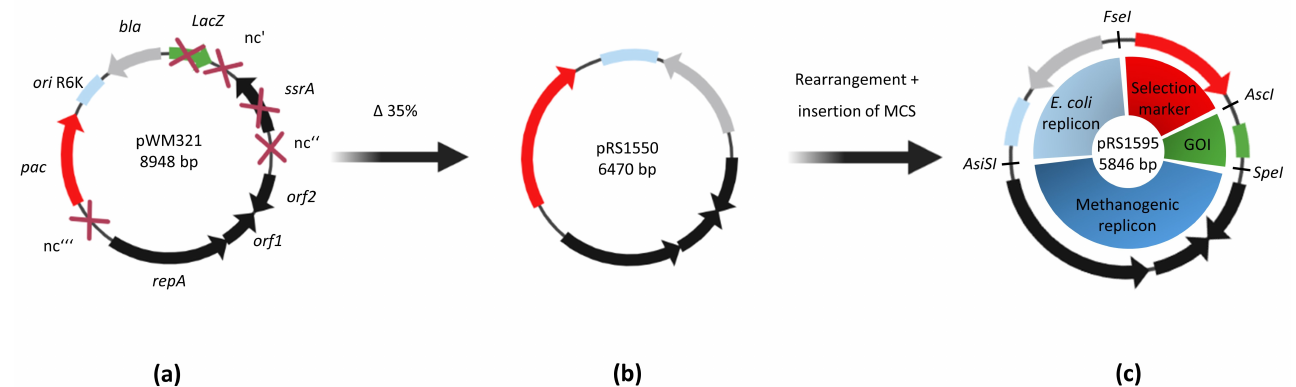
Figure 1. Plasmid maps of pWM321 and the shortest constructs pRS1550 and pRS1595. ( a ) Size reduction overview from pWM321. ( b ) The gene ssrA and parts of all non-coding regions from pWM321 were disposable resulting in pRS1550, which was about 2.5 kb smaller size. ( c ) In addition, the restriction enzyme recognition sites AscI , FseI , SpeI and AsiSI were introduced and the modules were rearranged resulting in pRS1595. The four modules are the replicon and the selectable marker for E. coli (origin R6K and bla gene), the replicon for M. mazei ( repA , orf1 and orf2 ), the selectable marker for M. mazei ( pac gene, red) and the gene of interest (GOI,